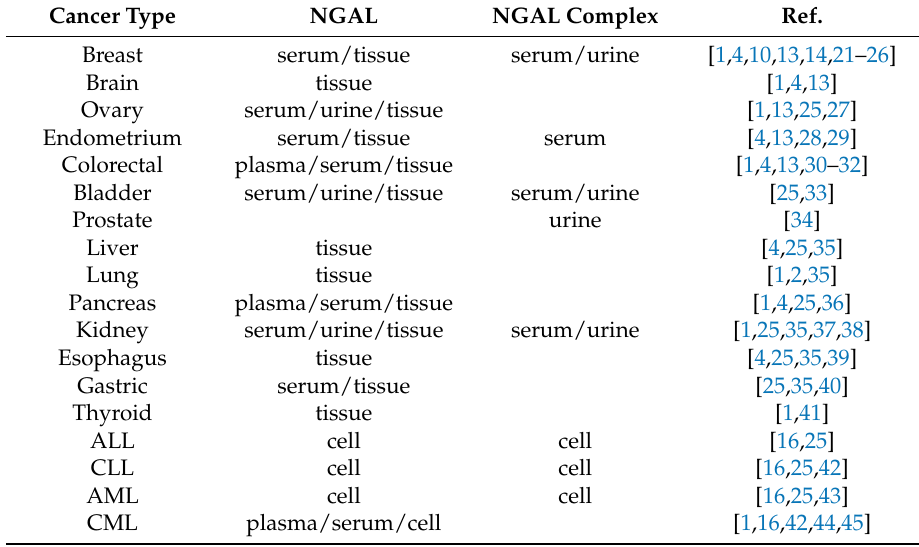
Table 1. Potential value of neutrophil gelatinase-associated lipocalin (NGAL) as a biomarker in solid tumors and